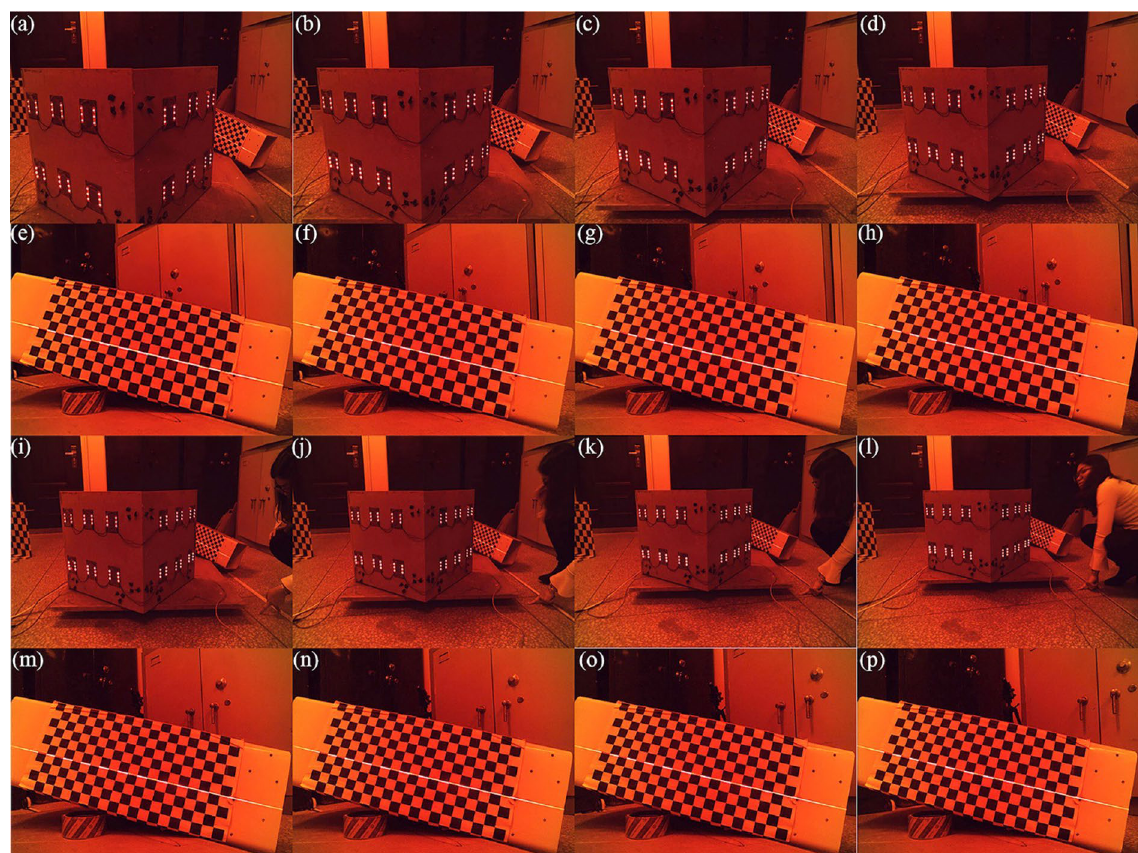
Figure 3. Experimental images of the internal and the external cameras. ( a – d ) the experimental images of the external camera. The camera-board distances are 600, 700, 800, 900 mm. ( i – l ) the experimental images of the external camera. The camera-board distances are 1000, 1100, 1200, 1300 mm. ( e – h ) and ( m – p ) the experimental images of the internal camera related to ( a – d ) and ( i – l ).